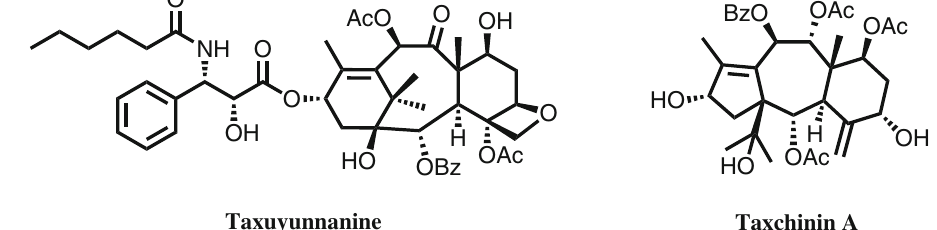
Fig. 3 Representative chemical constitutes of Taxaceae